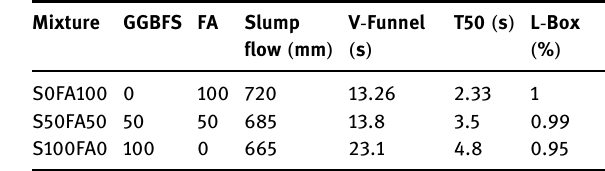
Table 5: The test result of fresh properties of